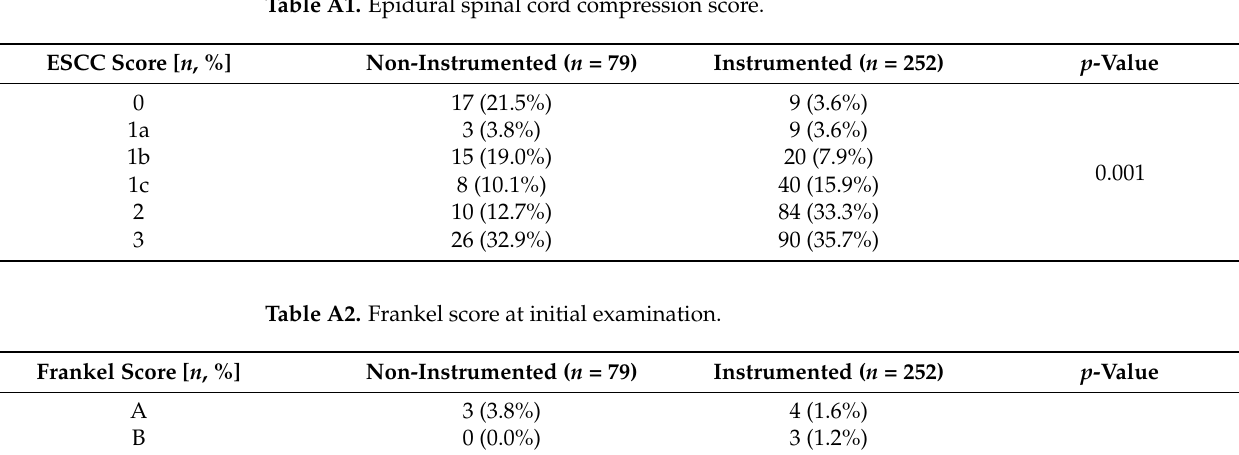
Table A1. Epidural spinal cord compression score.